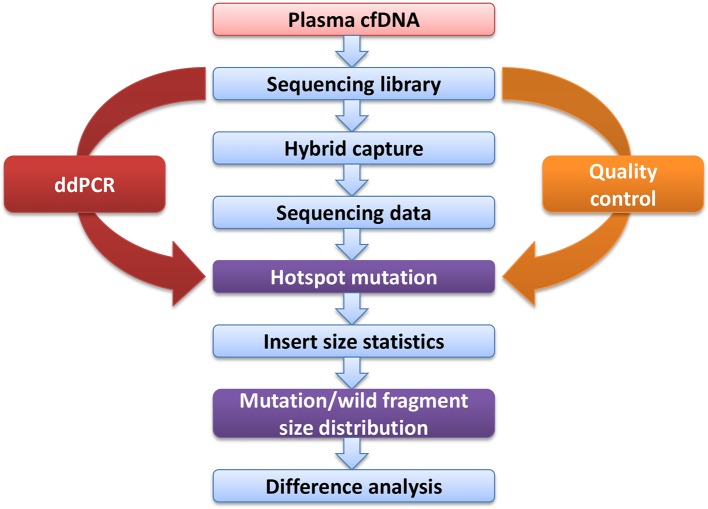
Experimental design flow.